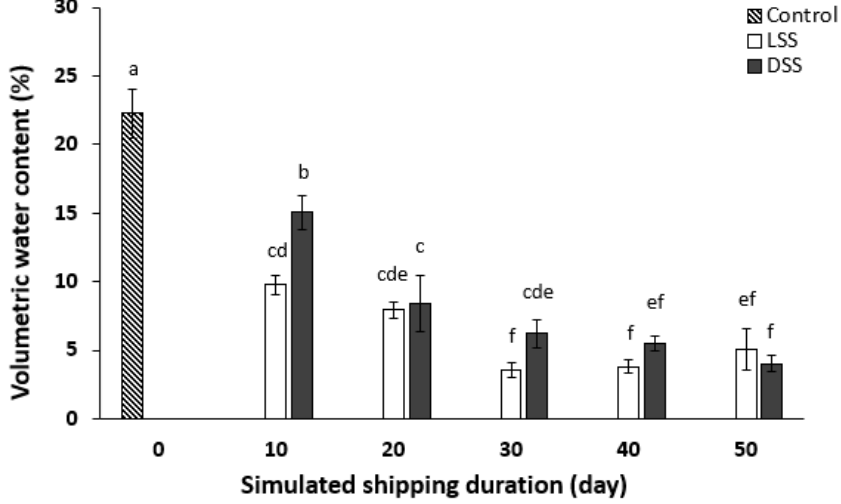
Figure 2. Volumetric water content of Sphagnum moss (potting media) at the end of each light (LSS) or dark (DSS) simulated shipping treatment as influenced by simulated shipping duration in Phalaenopsis Sogo Yukidian ‘V3’. Within-graph means followed by the same letter are not significantly different according to Duncan’s multiple range test at p ≤ 0.05.